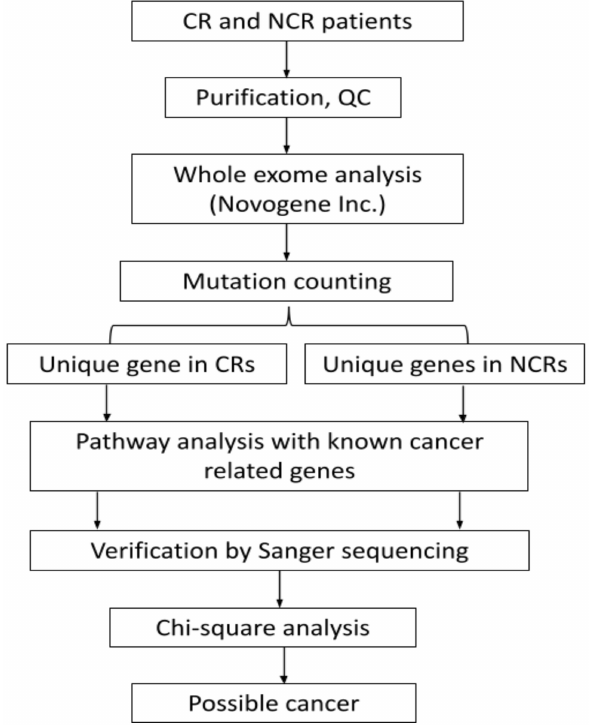
Figure 1. Flowchart of the analysis of commonly mutated genes in CR and NCR.